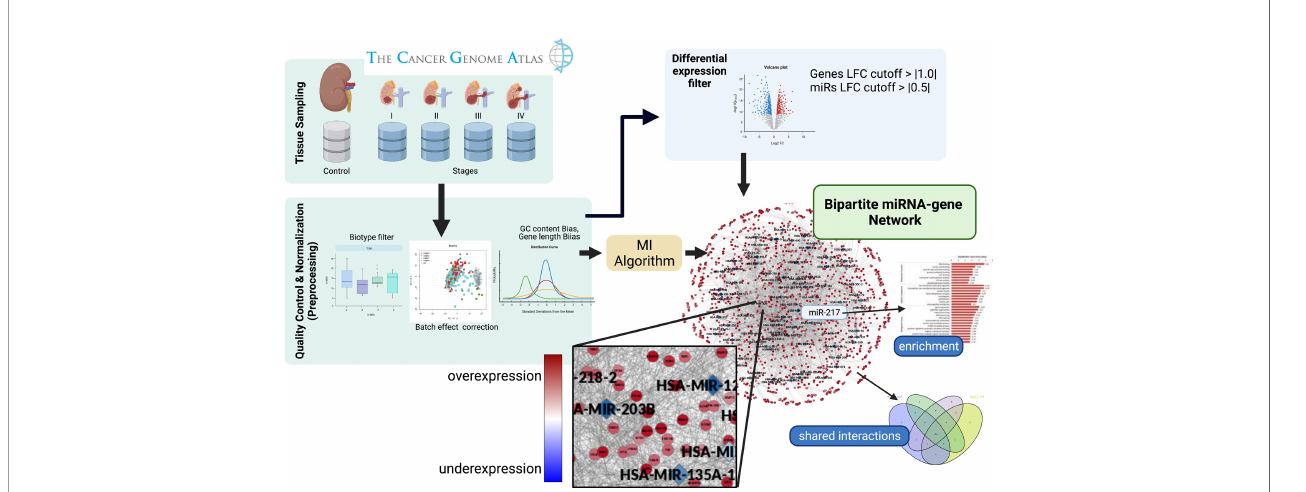
FIGURE 1 | Graphical pipeline. Firstly, sequencing data was obtained from the TCGA-GDC consortium. Secondly, a pre-processing phase was performed, where raw counts were fi ltered and normalized. Differential expression was calculated to retrieve genes and miRs whose expression became altered between contiguous stages. A bipartite co-expression network (miR – gene) for each progression stage was inferred. After that, we conserved those miR – gene interactions with miRs and genes with opposite differential expression. Finally, an enrichment analysis of the relevant genes obtained by the aforementioned pipeline was